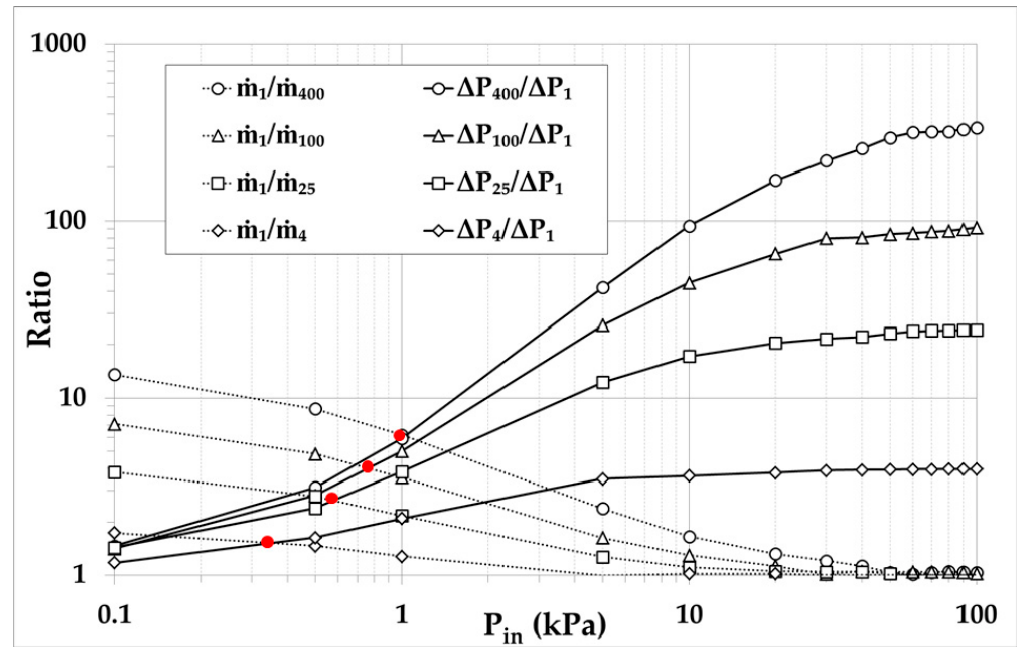
. . m 1 / m n and associated maximum pressure di ff erences / m m and associated maximum pressure 1 n